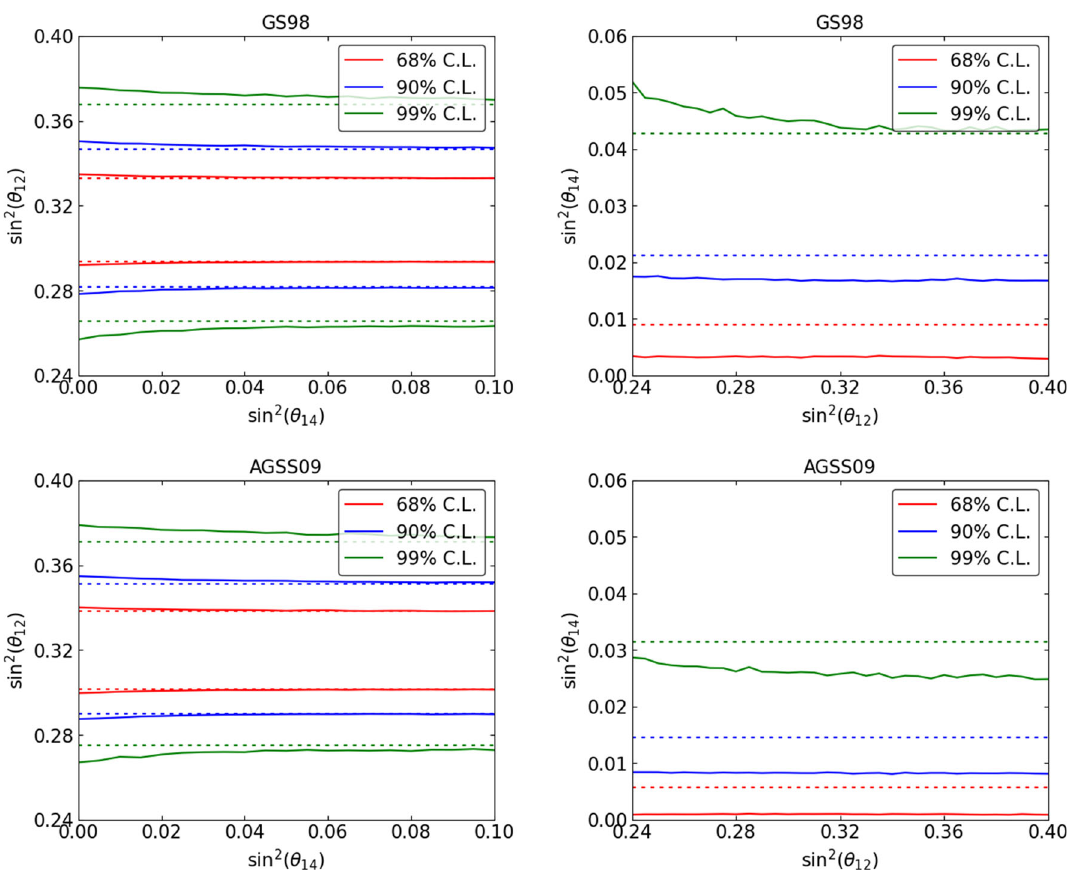
Fig. 5 Confidence interval at 68%, 90%, and 99% CL for s 2 and s 2 (right) as a function of the assumed true value of the other 14 parameter,respectively.Dottedlinesindicatethecorrespondinginterval